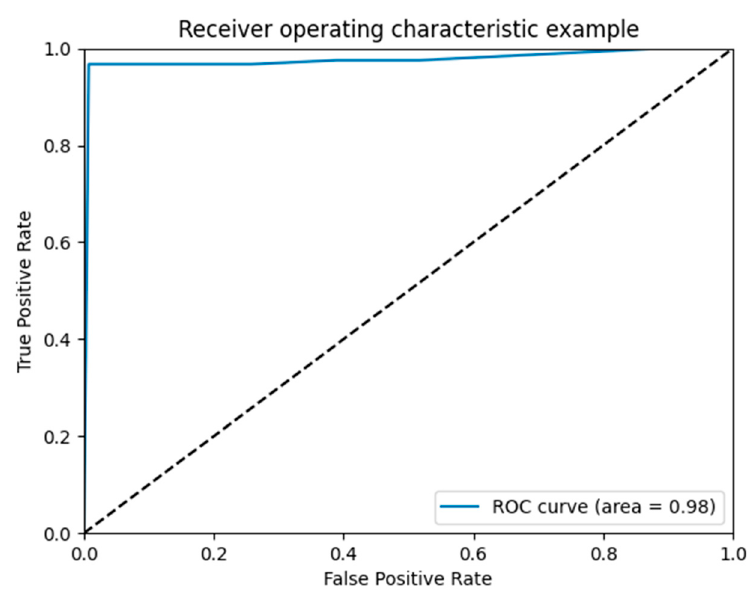
Figure 3. Confusion matrix.